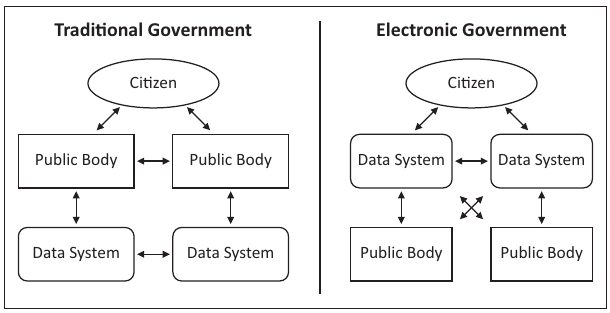
FIGURE 1: Traditional versus electronic